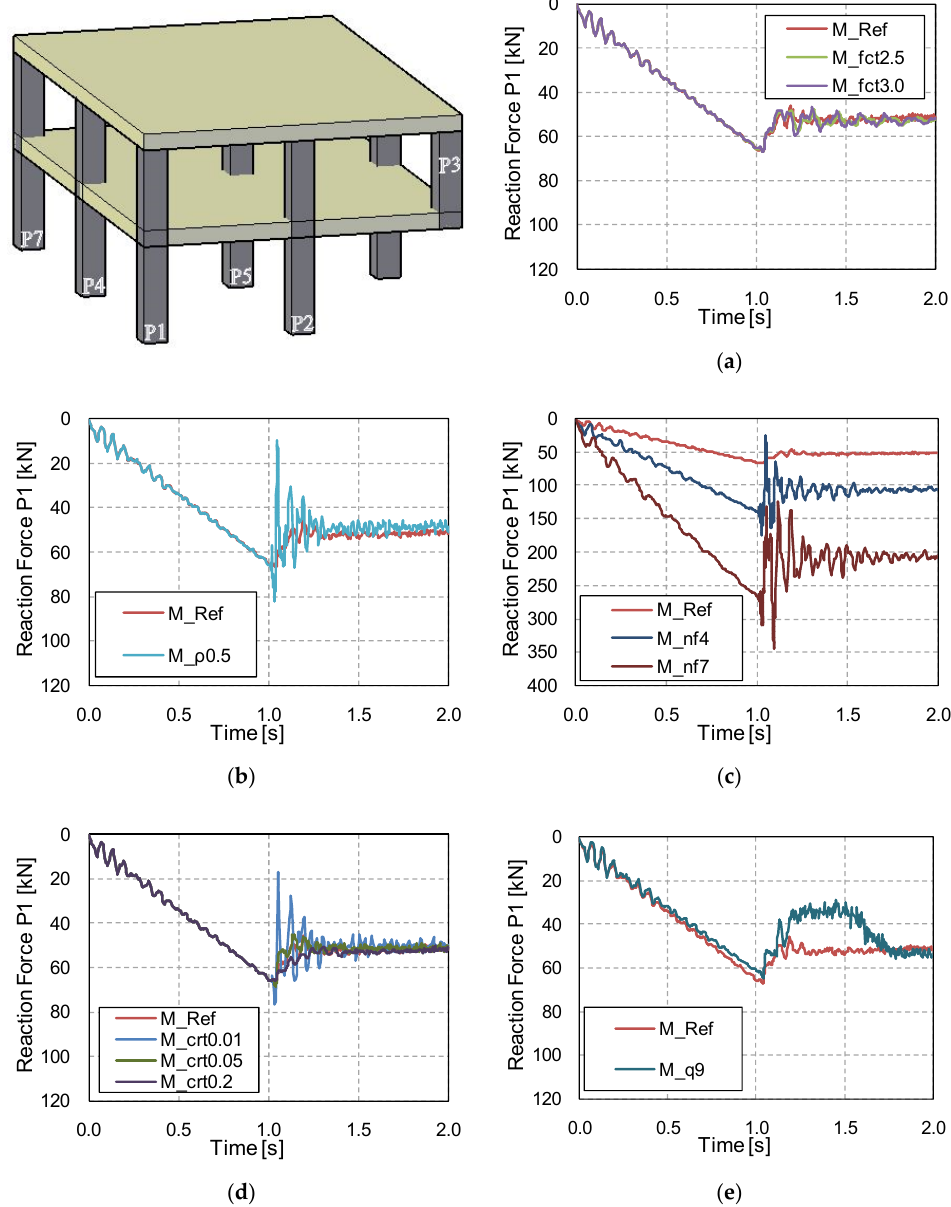
Figure A1. Numerical reaction in P1 obtained by varying ( a ) concrete tensile strength, ( b ) flexural reinforcement ratio, ( c ) number of floors, ( d ) column removal time and ( e ) superimposed load. Positive values indicate